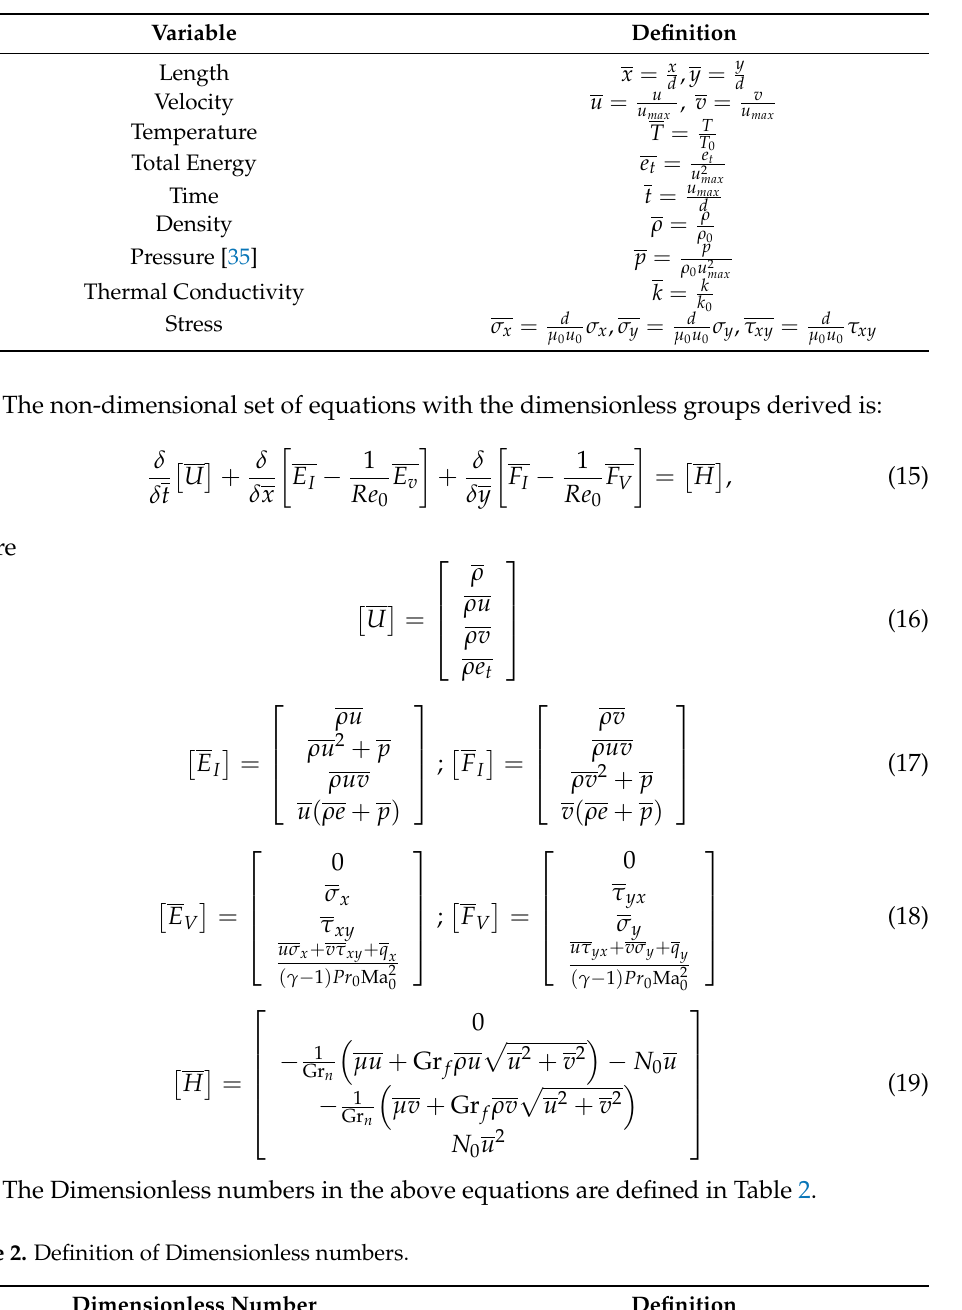
Table 1. Definition of the non-dimensional variables.